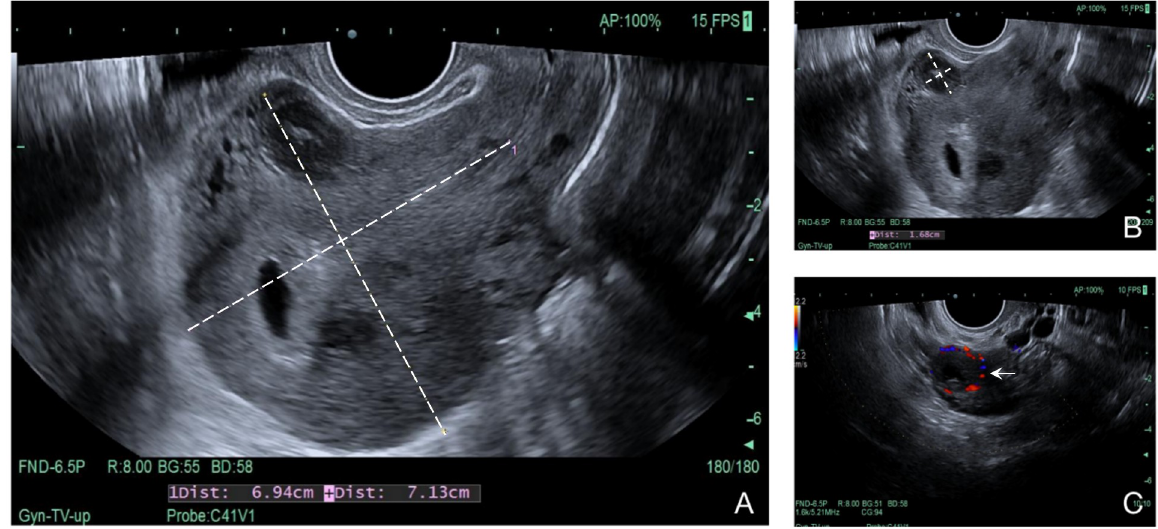
Figure 3. Ultrasound Results of case 2. ( A ) Uterine size showed by ultrasound. (6.94 cm × 7.13 cm). ( B ) The maximum size of leiomyomas (16 mm × 17 mm × 12 mm). ( C ) Extensive blood supply for the uterine